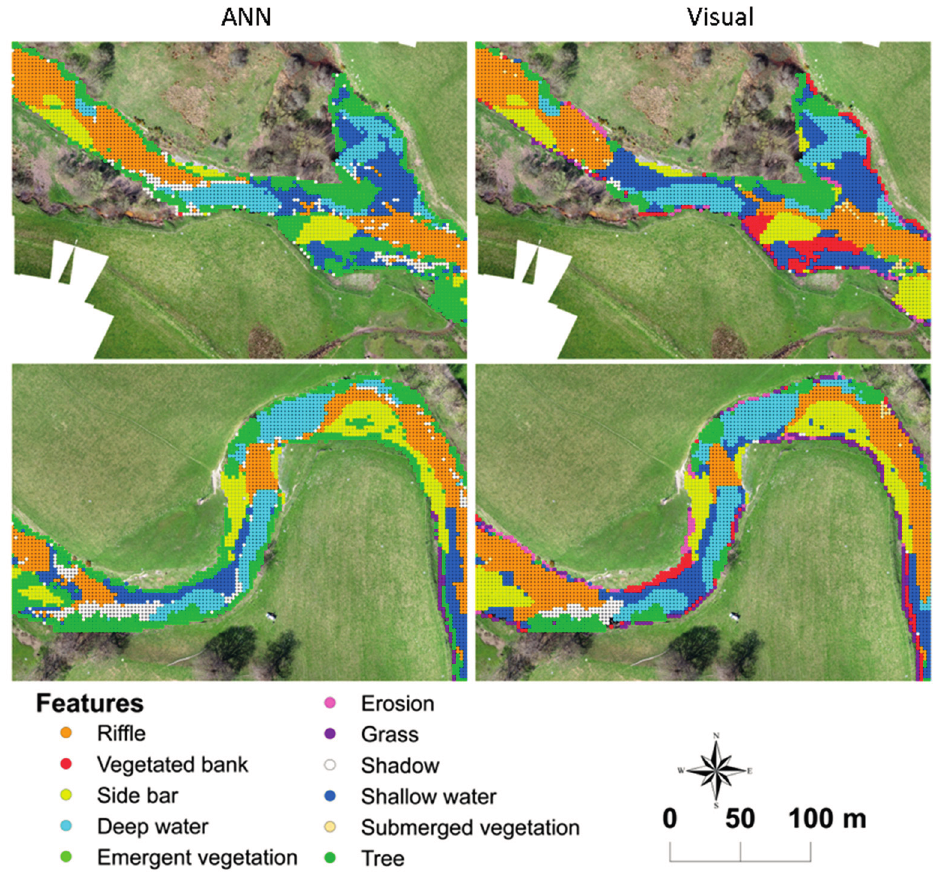
Figure 6. Classification outputs at each of the points defined by a 2 m × 2 m regular grid obtained with ( Left ) The Leaf Area Index Calculation (LAIC) Artificial Neural Network (ANN) and ( Right ) The visual identification for two sections within the study